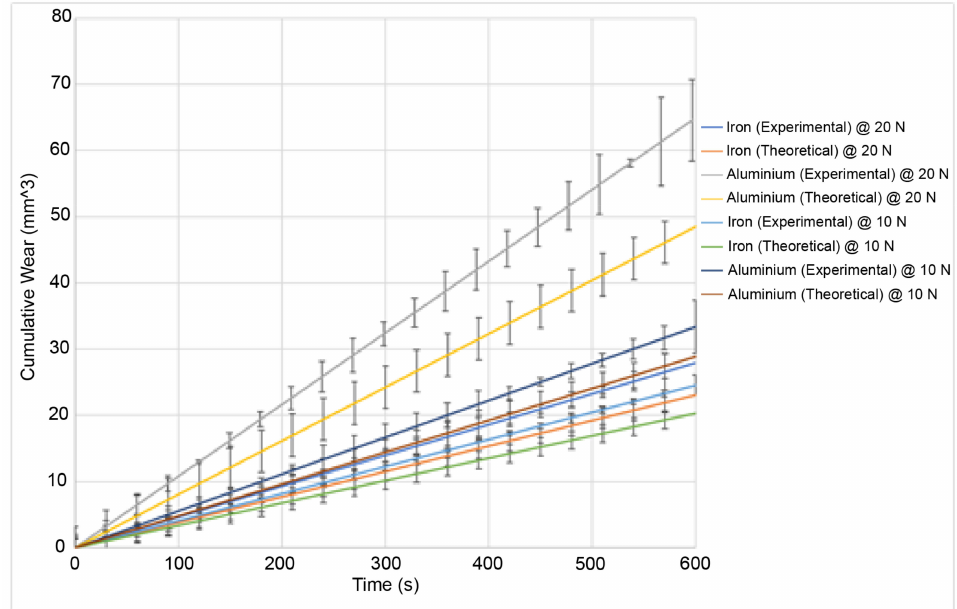
Figure 7. Experimental results for the wear at a 20 N load and 40 ◦ C for aluminium (grey) and iron (blue). Theoretical results at a 20 N load and 40 ◦ C for aluminium (yellow) and iron (orange). Experimental results at a 10 N load and 40 ◦ C for aluminium (violet) and iron (teal). Theoretical results at a 10 N load and 40 ◦ C for aluminium (brown) and iron (green).